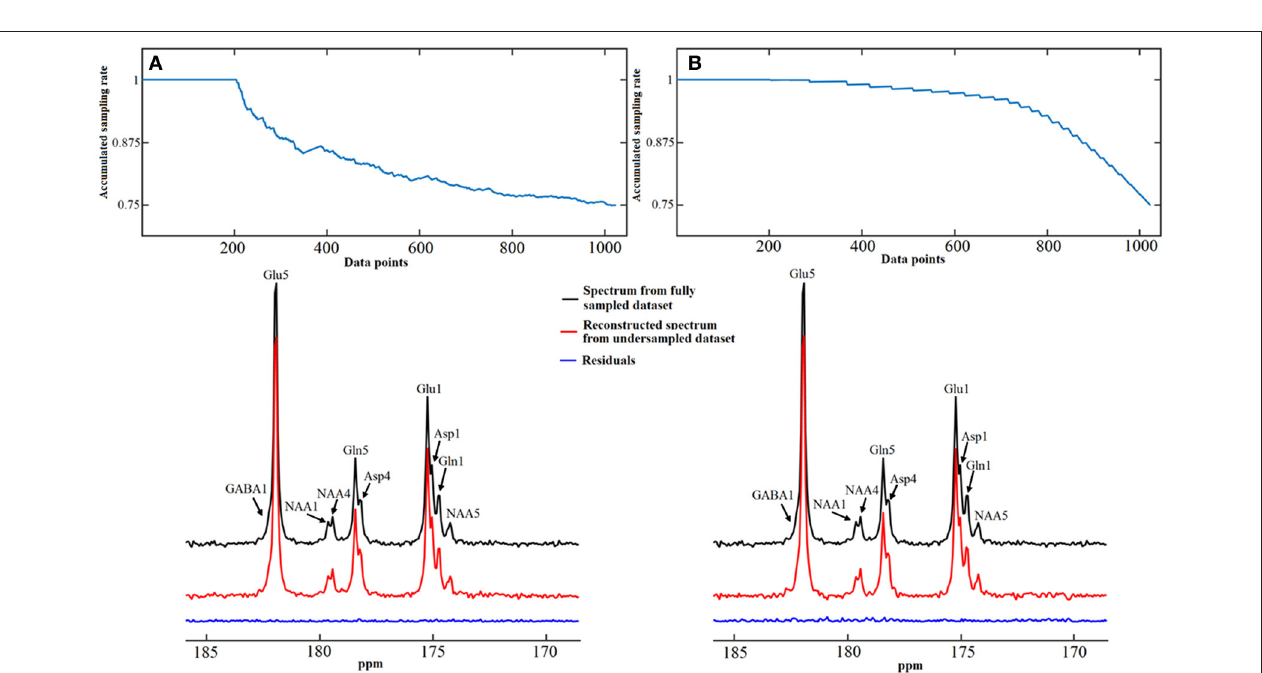
FIGURE 12 | Spectra reconstruction using time-domain random under-sampling strategies. Examples of data reconstruction using the total random sampling pattern (A) and coherent sampling pattern with gradually decreasing under-sampling rate (B) . The sampling patterns from top display accumulated sampling rate over sampled data points. The last point of sampling pattern represents the overall under-sampling rate, which is 25%. Both methods began with a 20% fully sampled core. Adapted from Li et al. [36].